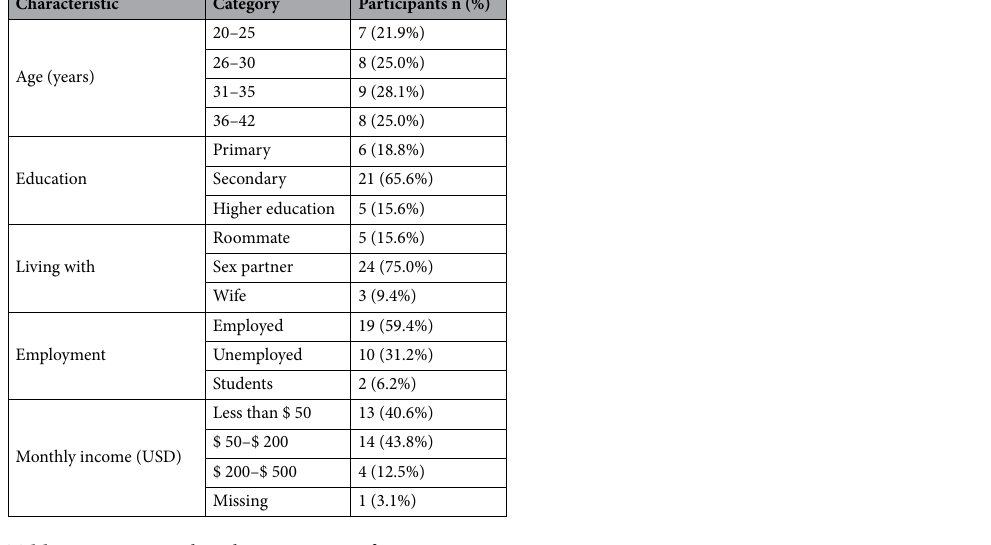
Table 1. Demographic characteristics of 32